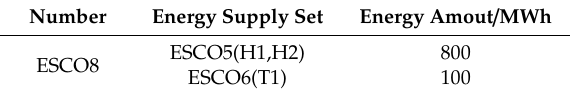
Table 6. Simulation results of ESCO8 in the EBN.